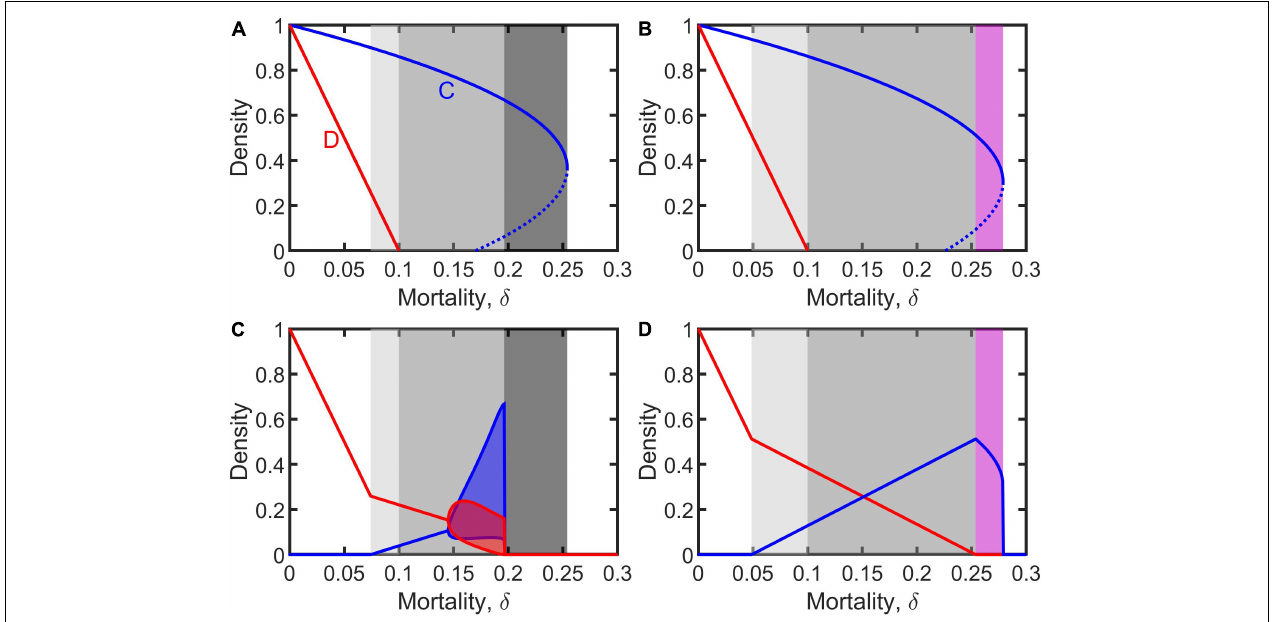
FIGURE 1 | Equilibrium density of cooperators and defectors (denoted by blue and red), as a function of mortality, when living alone (A,B) or coevolving together (C,D) . Light gray indicates that cooperators and defectors can persist separately and also coexist; gray represents that they can coexist but defectors cannot survive alone; dark gray represents that defectors can invade cooperative population but leading to the entire population to go extinct; and purple represents that defectors cannot invade cooperative population. Dashed lines on panels (A,B) indicates unstable equilibrium. Blue and red shadows on panel (C) represent the fluctuant range of densities in periodic solutions. Parameters: b = 1, c = 0 . 3, ξ = 0 . 1, and m = 0 . 1 for panels (A,C) representing the case of 0 < m < c ( b − c − ξ) 2 b ( b − c ) and m = 0 . 18 for panels (B,D) representing the case of c ( b − c − ξ) 2 b ( b − c ) < m < c b (see first paragraph in Results). Supplementary Figure 1 in Supplementary Materials shows the similar results with different parameter